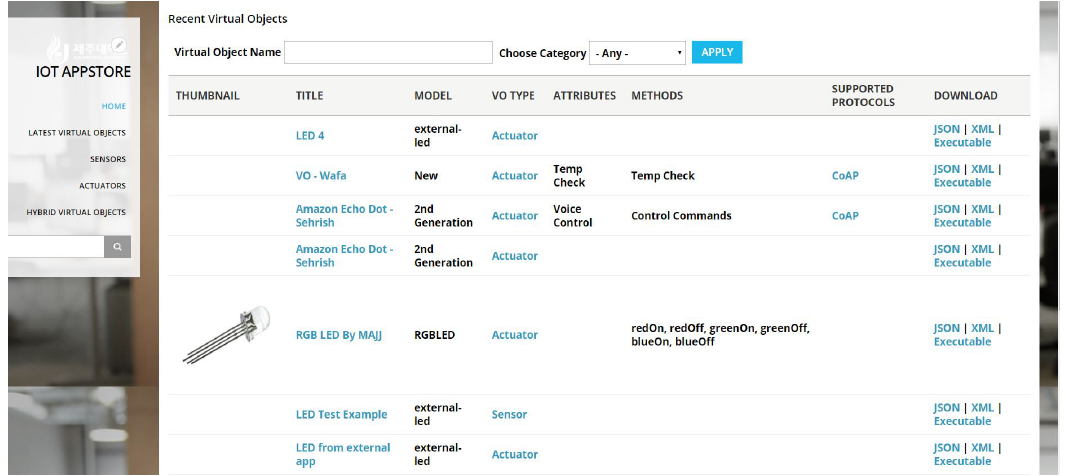
Figure 10. Virtual objects management on the application